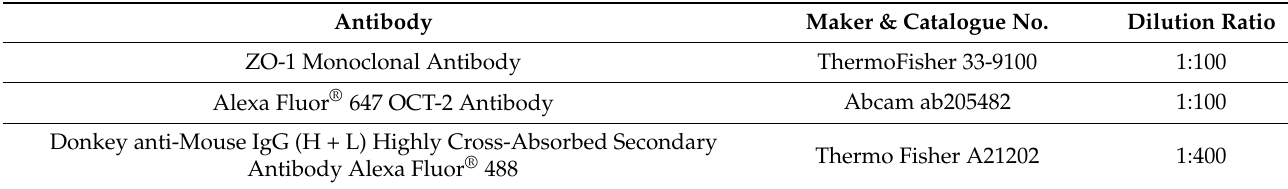
Table 1. Antibodies and dilution ratios for immunostaining.